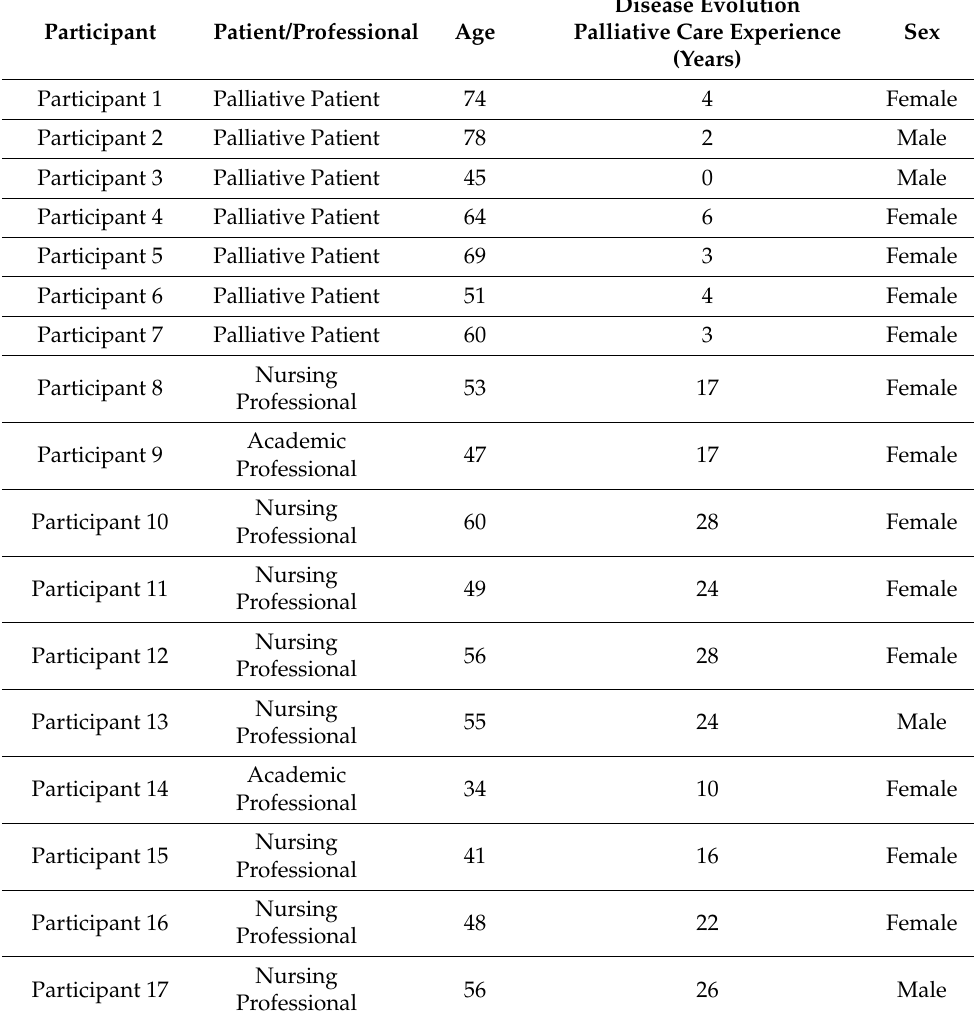
Table 2. Sociodemographic characteristics of those